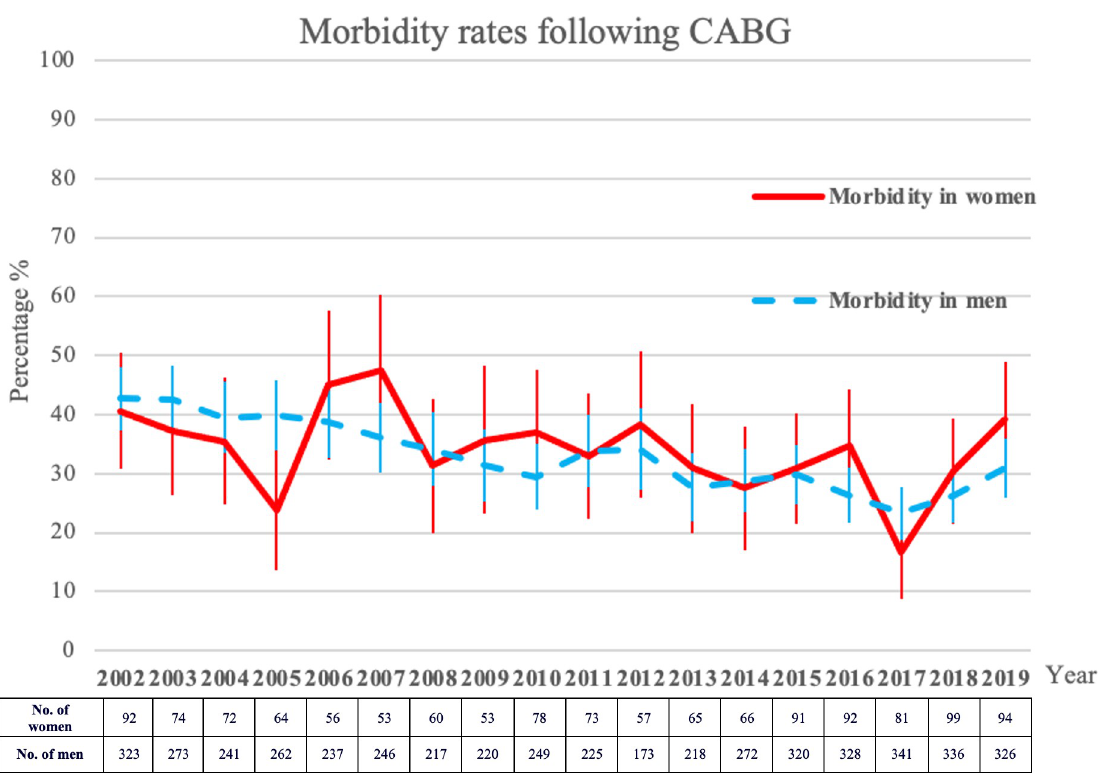
Fig 2. Mortality rates following CABG surgery in male and female patients.